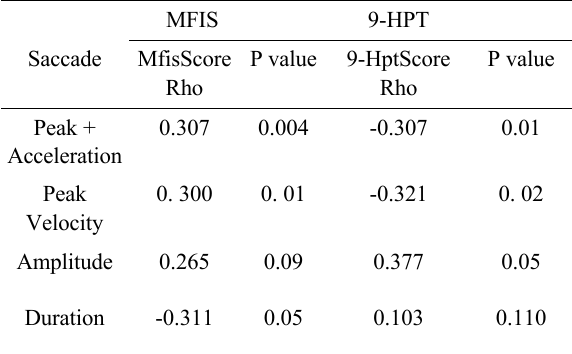
Table 6. Correlations (Spearman Rho) between IR-OG results after stress test with MFIS Cog,